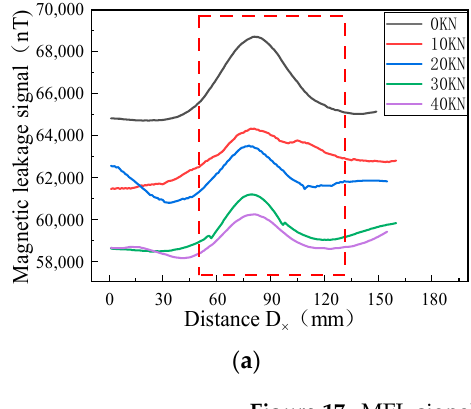
Figure 17. MFL signals under different stresses. ( a ) Axial component of MFL signals. ( b ) Radial component of MFL signals.